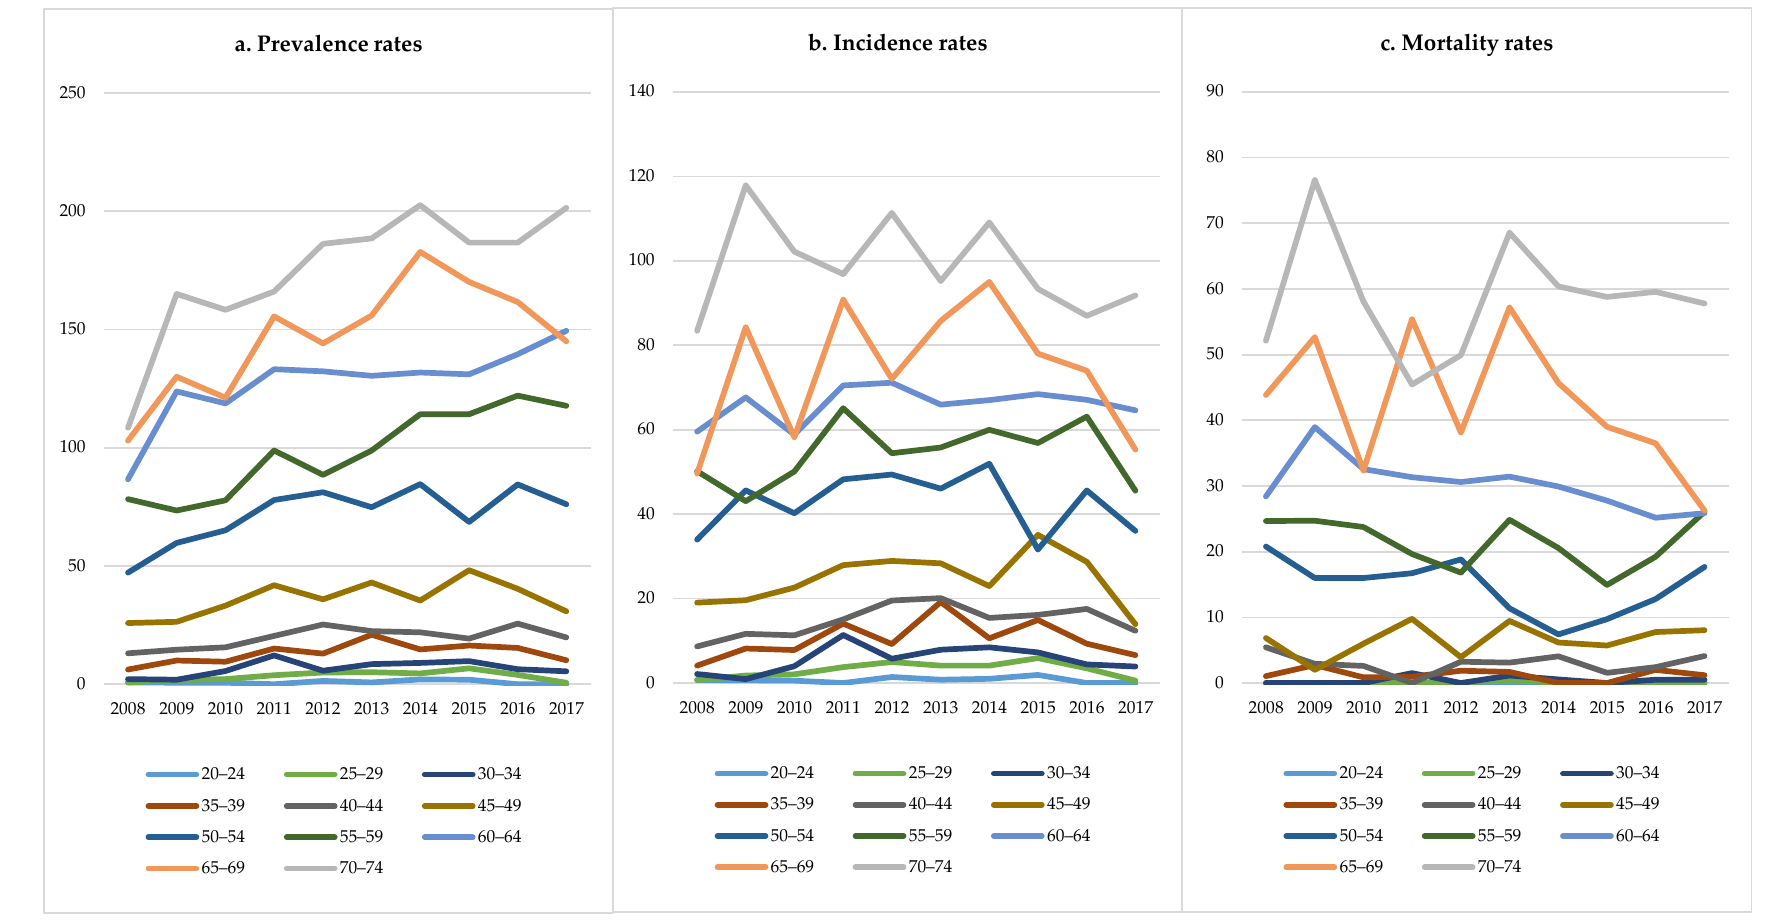
Figure 3. Temporal trends of the prevalence, incidence, and mortality rates of HCC by age group from 2008 to 2017. Note: As there was no apparent trend among individuals aged 75−79, 80−84, and ≥85, these three age groups were not shown to enhance the clarity and readability of this figure.